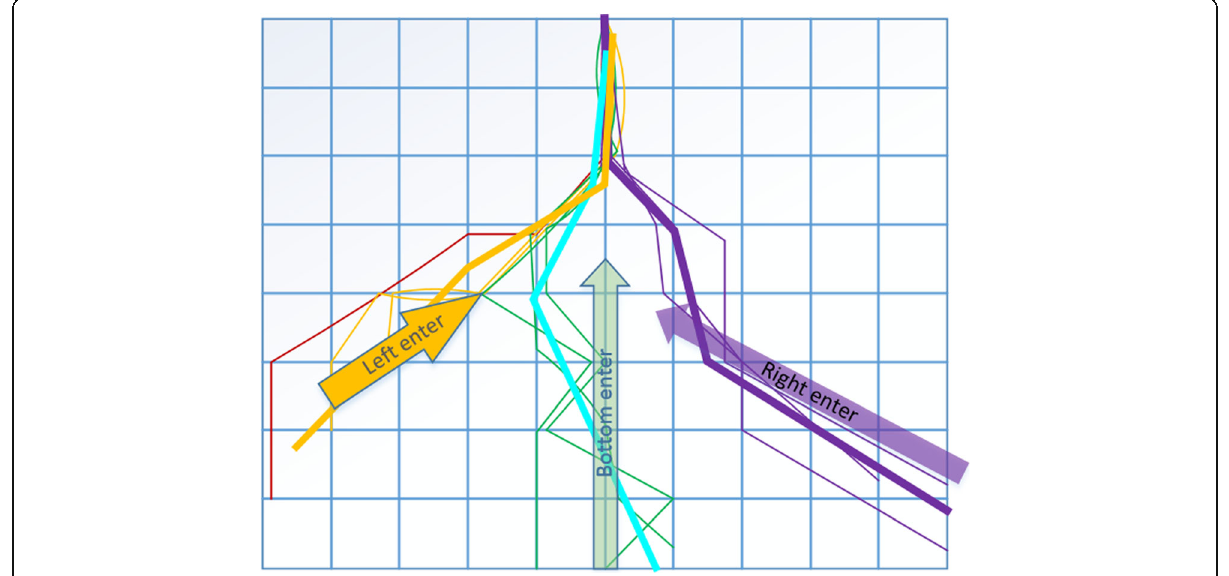
Fig. 15 Erob into the target area (any point). The trajectory of the Erob in the grid, which can eventually reach the target